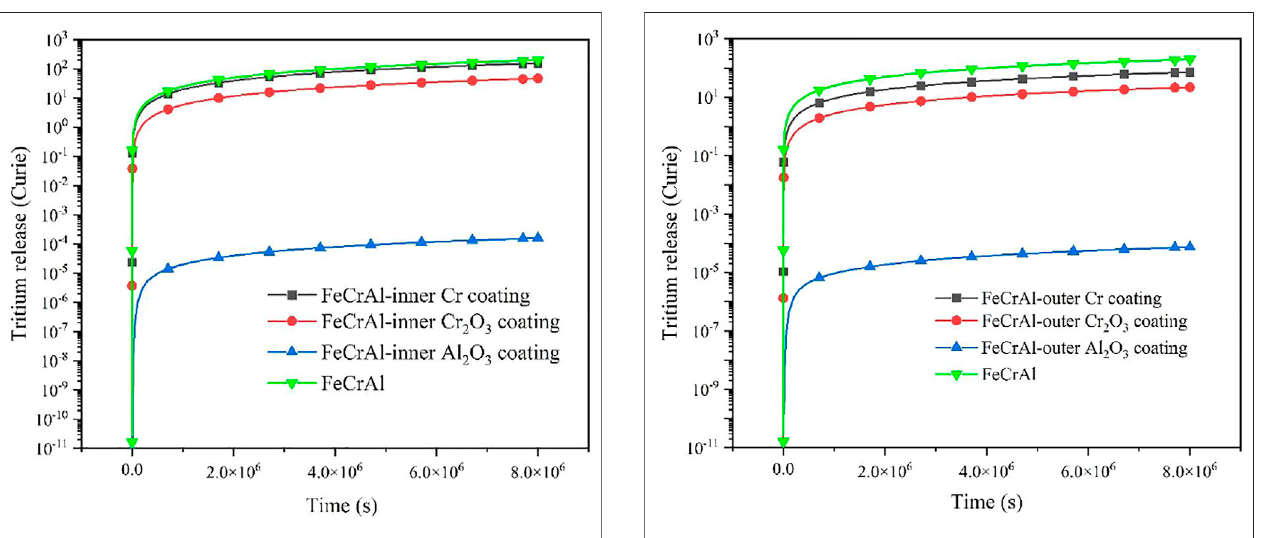
FIGURE 18 | Total tritium release when the coating is on the inner surface of the FeCrAl cladding.